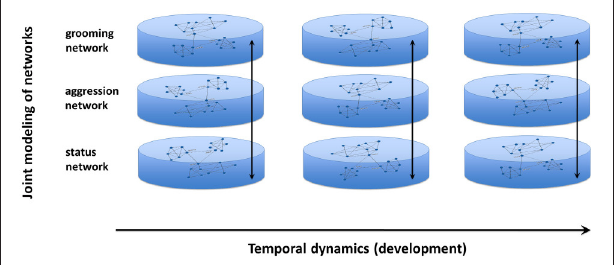
FIGURE 3 | Conceptual framework behind joint modeling of networks. Using this new technique, multiple networks can be evaluated for how they correspond to one another and how that correspondence changes over time, across development, during the aging process, or over the lifespan.